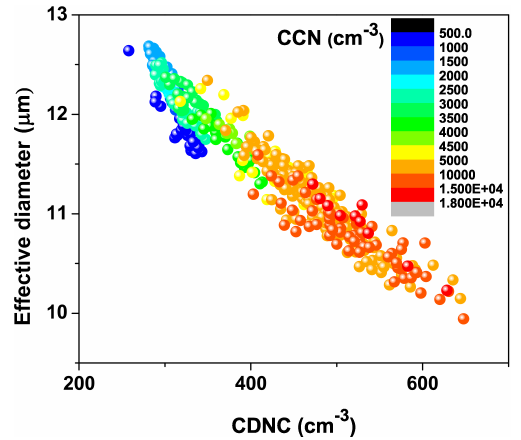
Figure 1. Variation of cloud microphysical parameters (droplet number concentration and effective diameter) with CCN number concentration.